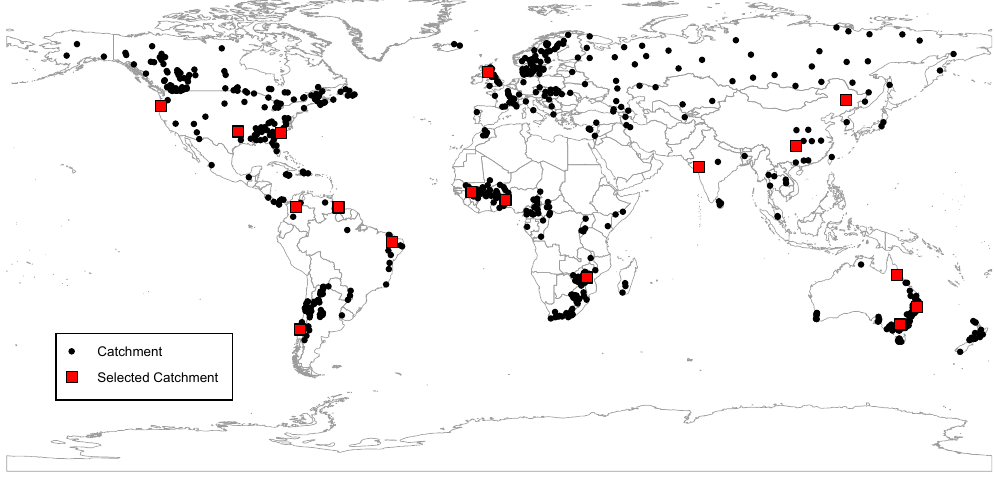
Figure 3. Locations of the initial 699 catchments and the final sub-set of 17